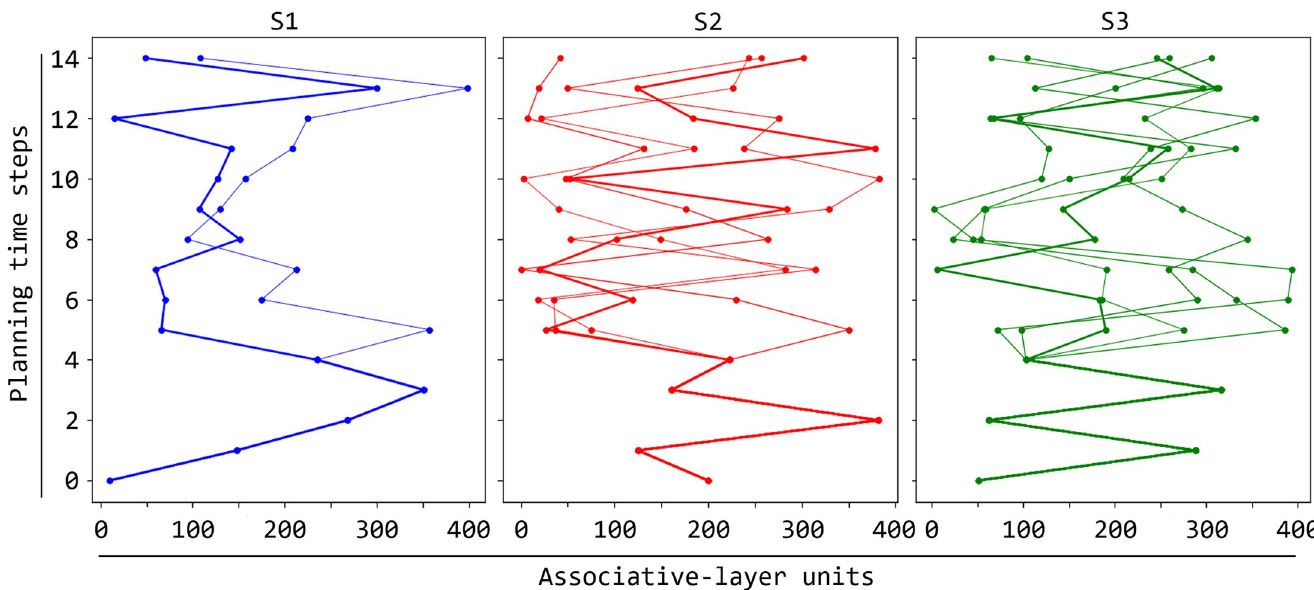
Fig 8. Possible neural trajectories simulated by the model during planning. The three graphs show different neural trajectories that the associative component can generate for respectively the three colours S1, S2, and S3. For each graph, the x-axes indicates the associative neurons and the y-axis the planning time steps and a dot indicates that the corresponding neuron was active. The bolder curve within each graph marks the correct trajectory for the pursued goal ‘correct feedback’.